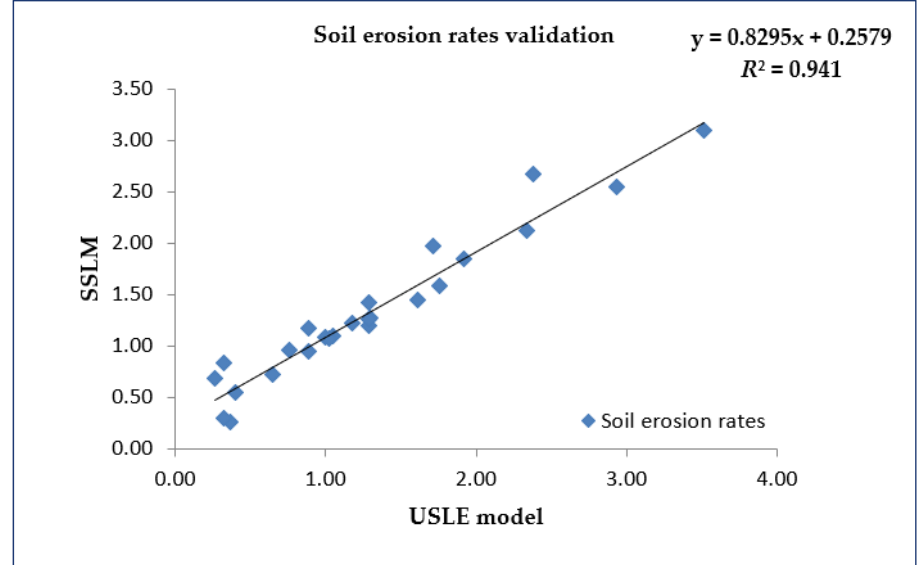
Figure 16. Linear relationship between the USLE model and the proposed model (SSLM).